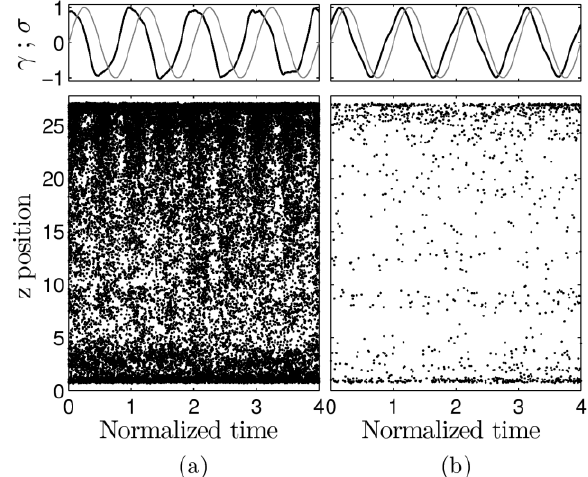
Figure 6. Stress (black)-strain (gray) relationship (top row) and spatial-temporal plots of aggregate formation (lower row) as a function of normalized time t / T , where T is the period of the oscillation. Each point in the spatial-temporal plots locates the formation of an aggregate within time. Panes in ( a ) correspond to the frequency-amplitude combinations ω = 6.28 × 10 − 4 , γ 0 = 3.59; and ( b ) ω = 6.28 × 10 − 3 , γ 0 = 0.36.